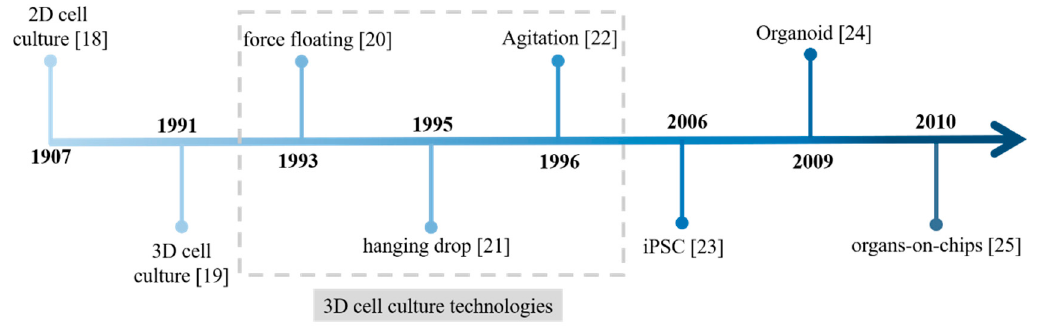
Figure 1. A brief history of the development of in vitro tools. iPSC: induced pluripotent stem cells [18–25].